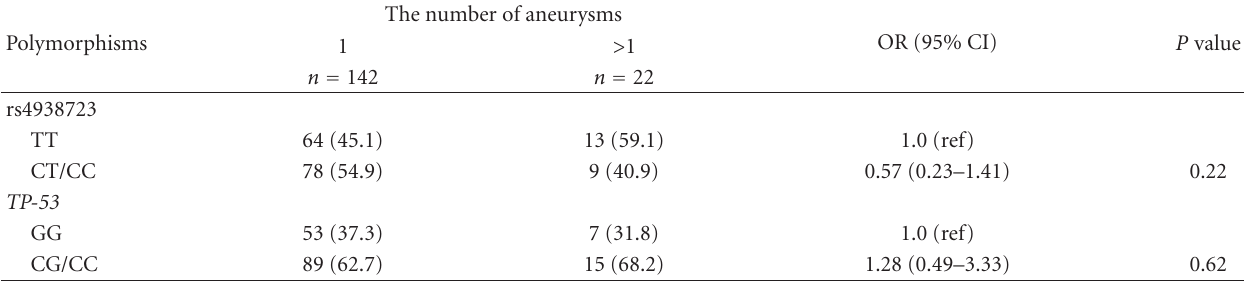
Table 7: Stratified analysis by the number of